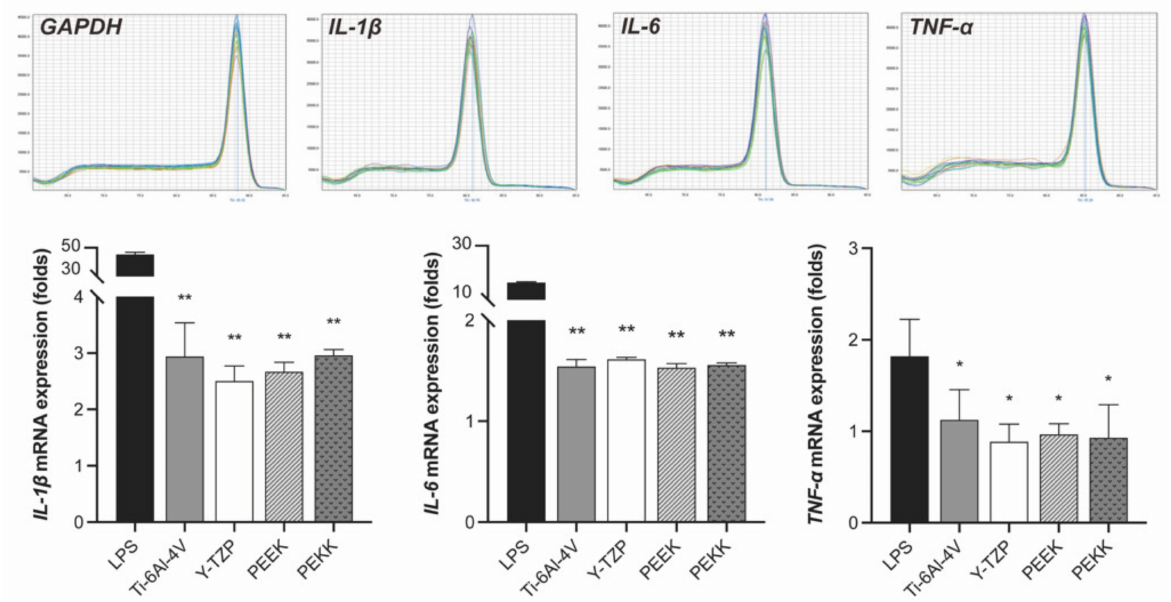
Figure 5. Gene expression of pro-inflammatory cytokines ( IL-1 β , IL-6 , and TNF- α ) in HOF after 24 h of cultivation in testing extracts (Ti-6Al-4V, Y-TZP, PEEK, and PEKK). One-way ANOVA with a post-hoc Tukey HSD test was conducted for multiple comparisons with the LPS group. (* p < 0.05, ** p <